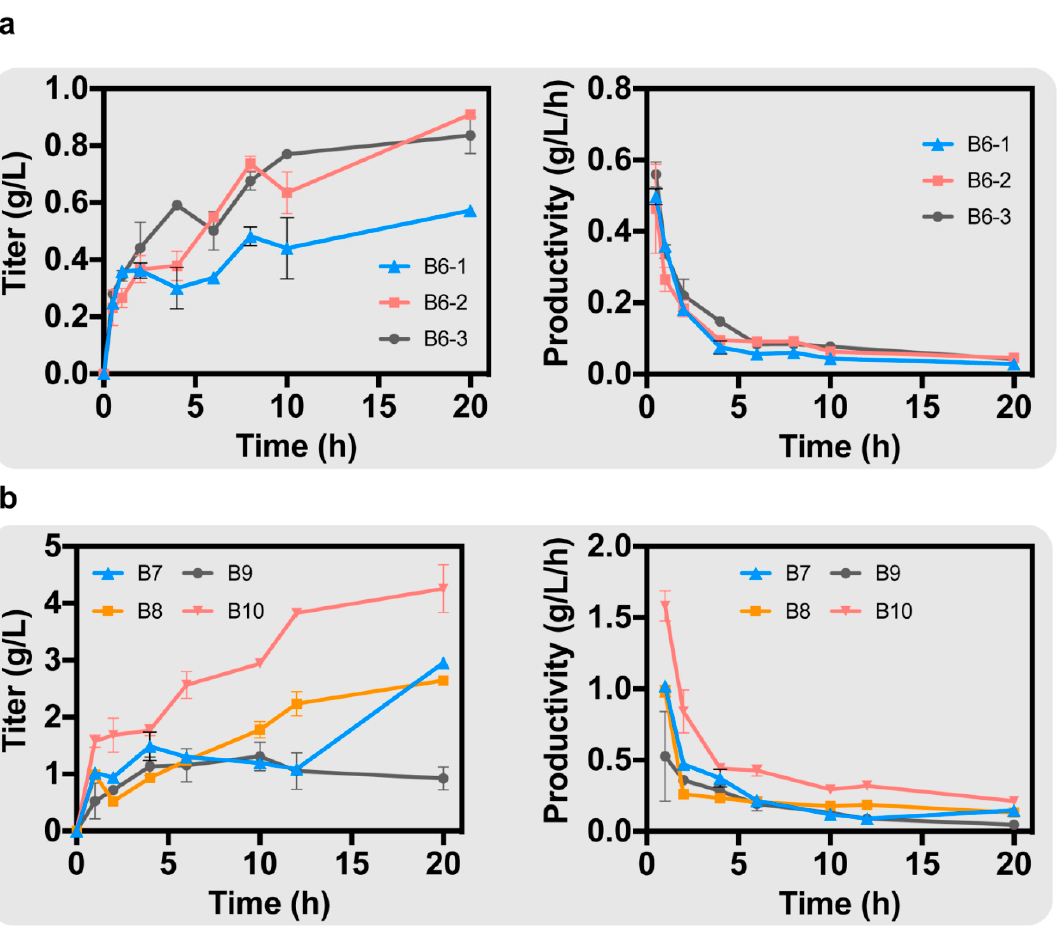
Figure 4. ( a ) After knocking out the degradation pathways of glycine and arginine in B. subtilis , the GAA production of different strains was obtained. ( b ) After enhancing the endogenous ornithine cycle in B. subtilis , the GAA production of different strains was obtained.